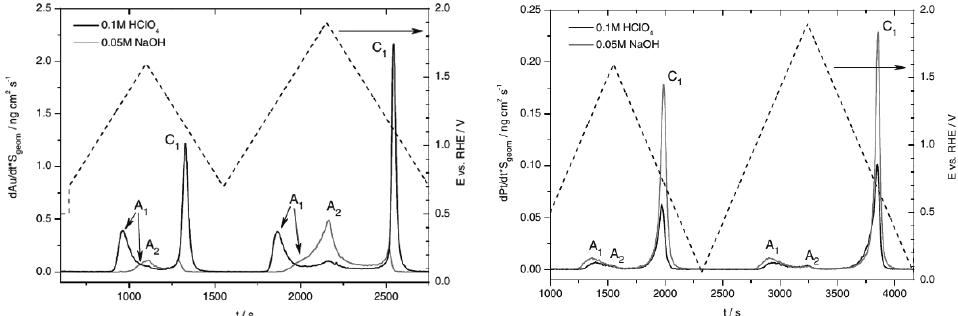
Fig. 19. – By coupling a mass spectrometer to an electrochemical flow cell, the group of Mayrhofer was able to study noble metal corrosion in detail. The dashed lines indicate the applied potential while the solid signals quantify dissolved noble metal ions [80]. The inves- tigation of gold corrosion (left) and platinum corrosion (right) show that for both cases no continous corrosion occurs, but noticable amounts of noble metal are dissolved while reducing the oxide formed at higher potentials. Figure reproduced from [81] under Creative Commons licence (Attribution-NonCommercial-NoDerivatives 4.0 International CC BY-NC-ND